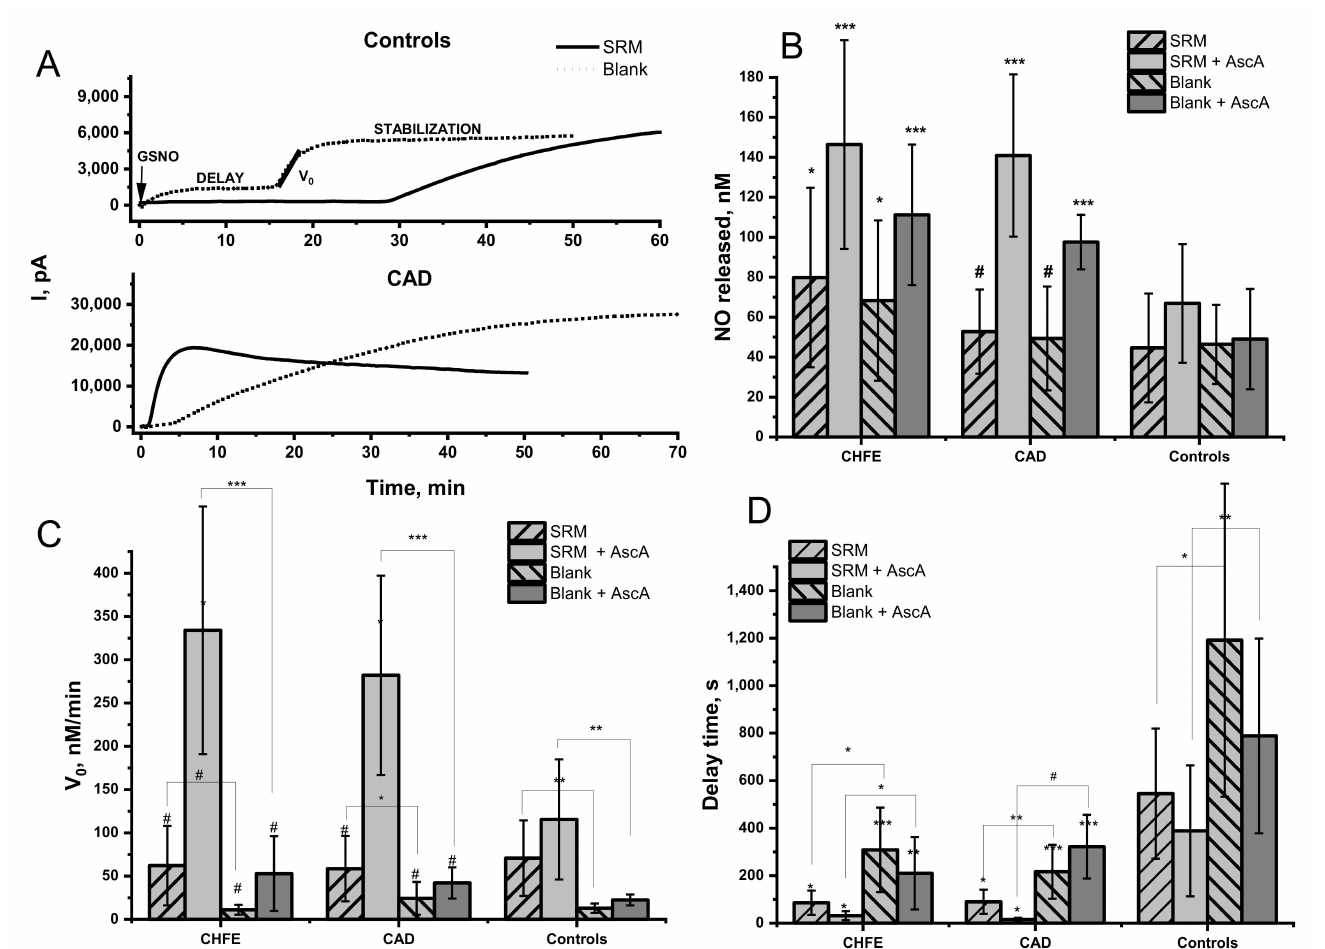
Figure 1. NO release from GSNO in 20-fold diluted blood plasma environment from CHFE ( n = 7), CAD ( n = 8) and controls ( n = 15) participants in the absence (blank) or the presence of 10% vol. of SRM aqueous extract without or with the addition of 1 µ M of ascorbic acid (AscA). Measurements were performed using NO electrode in Tris buffer 0.1 M, pH = 7.4, T = 37 ◦ C in the presence of 5 µ M of GSNO, in the dark. Measurements of the samples were performed in triplicates. The data represent the mean ± SD. The values of * p < 0.05, ** p < 0.01, *** p < 0.001 vs. controls, were considered significant; # p > 0.05. ( A ) Typical NO release profiles ( A ) and the calculated: the mean amount ( B ), the initial rates ( C ) and the delay time ( D ) of NO